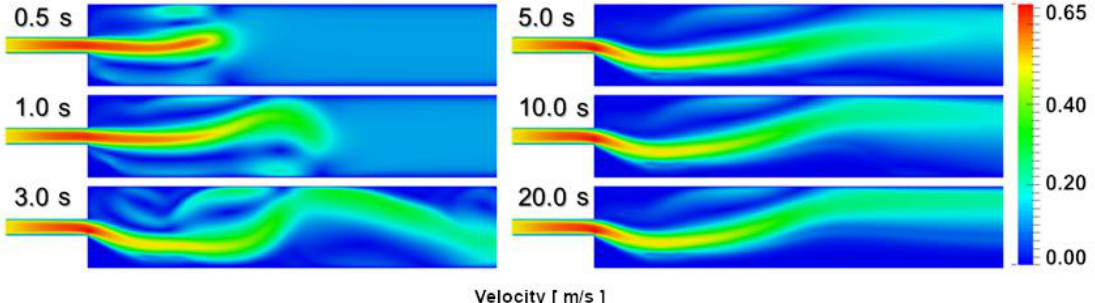
Figure 3. The velocity fields at different time steps with considering the gravity and using the proposed particle flux model.